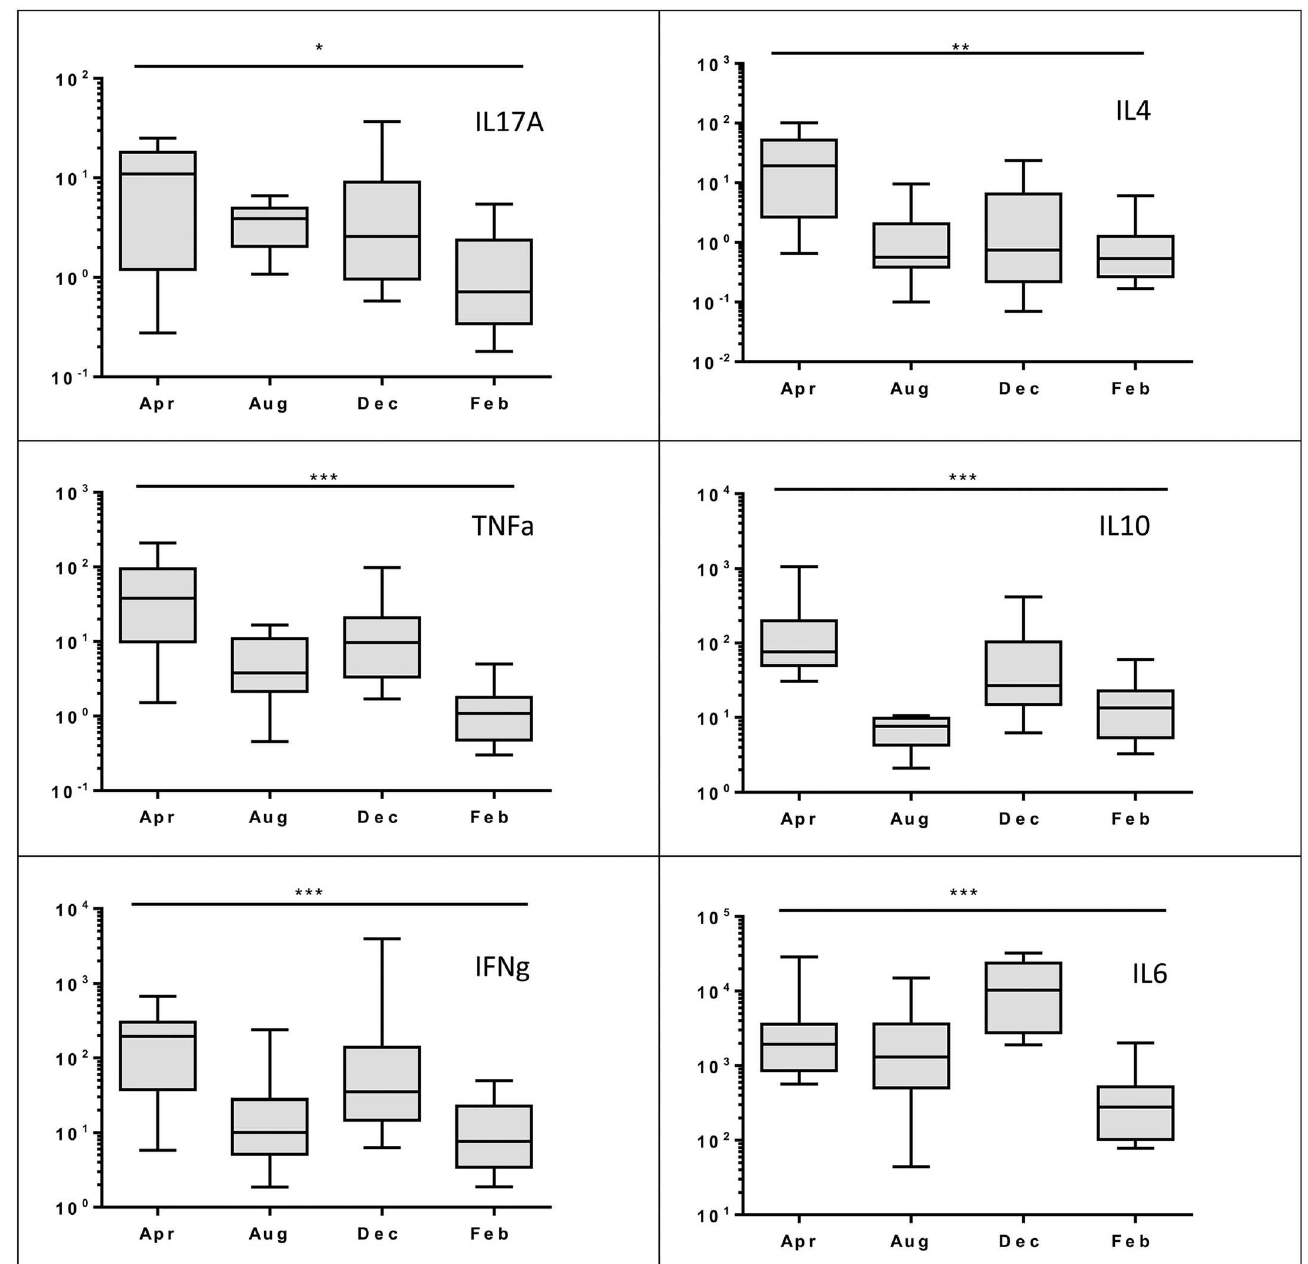
Fig 3. Seasonal difference in baseline cytokine levels. * p < 0 . 05 , ** p < 0 . 01 , *** p < 0 . 001 Kruskal-Wallis one-way ANOVA. Results are relative expression of cytokine levels compared to reference genes calculatedusing the Δ Cq method [43]. Box represents the 25 th to 75 th percentiles, middle line is median and whiskers are the minimum to maximum